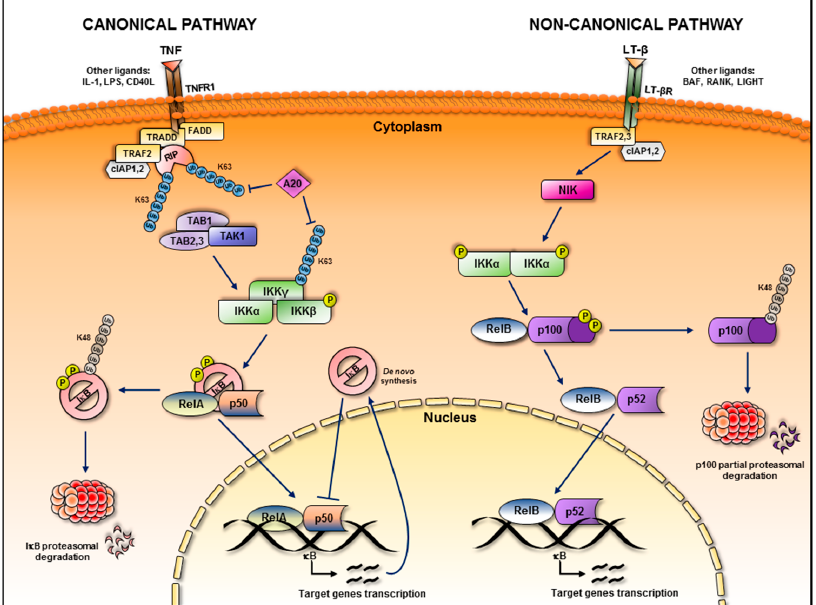
Figure 1. Activation pathways for canonical and non ‐ canonical NF ‐κ B signalling. Canonical NF ‐κ B pathway is exemplified by TNF ‐α binding to its reception, while non ‐ canonical NF ‐κ B pathway is illustrated by binding of LT ‐β to its